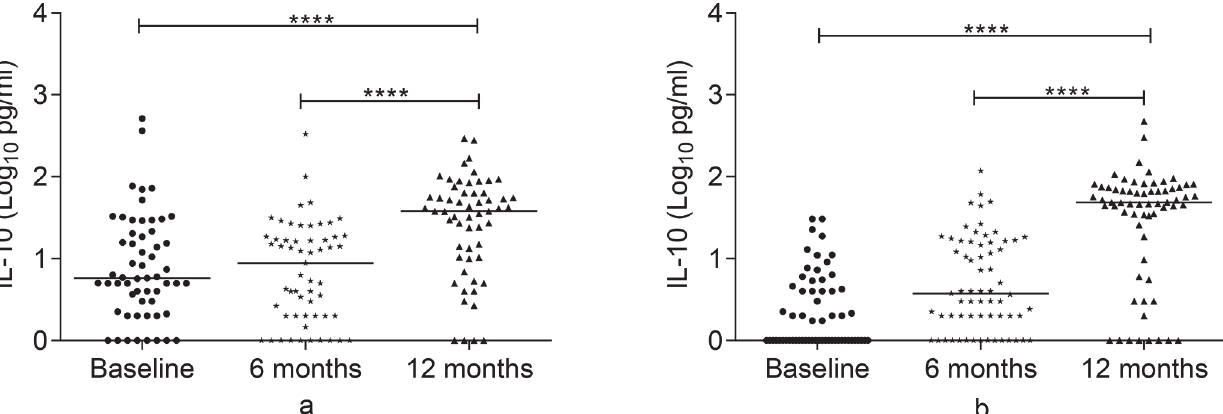
Fig 6. Changes in IL-10 responses to Rv2301 over 12 months in patients and contacts. IL-10 response over 12 months in patients (a) and contacts (b) following whole blood stimulation with Rv2031 for 48 hours. Filled circles represent baseline levels, filled diamonds represent 6 month levels and filled triangles represent 12 month levels. Results are individual responses and cytokine levels are expressed as log 10 pg/ml. Horizontal bars are medians. Freidman test with Dunn ’ s multiple comparisons was used to compare IL-10 response over time. **** p < 0.0001.